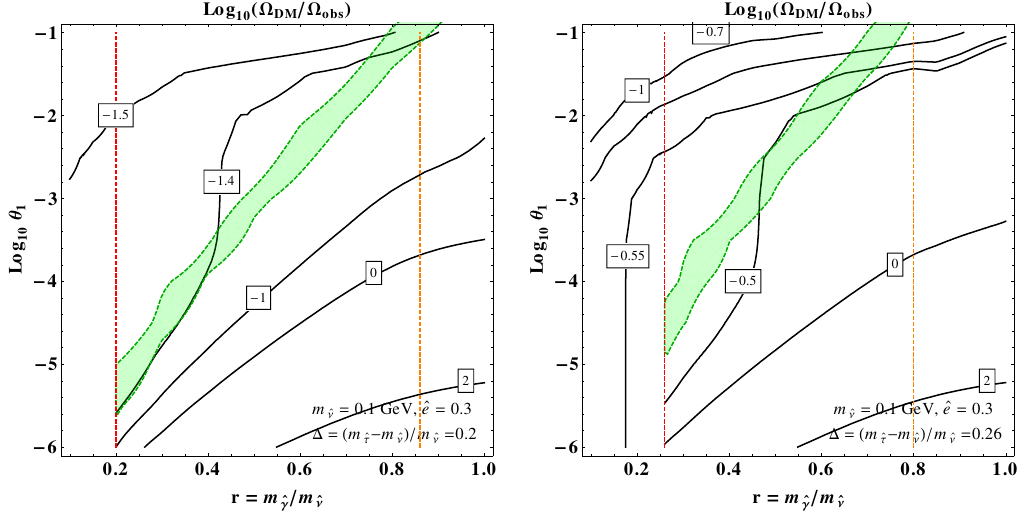
Figure 5 . Similar to (cid:12)gure 4, but for m ^ (cid:23) = 100 MeV and (cid:1) = 0 : 2 and 0.26.